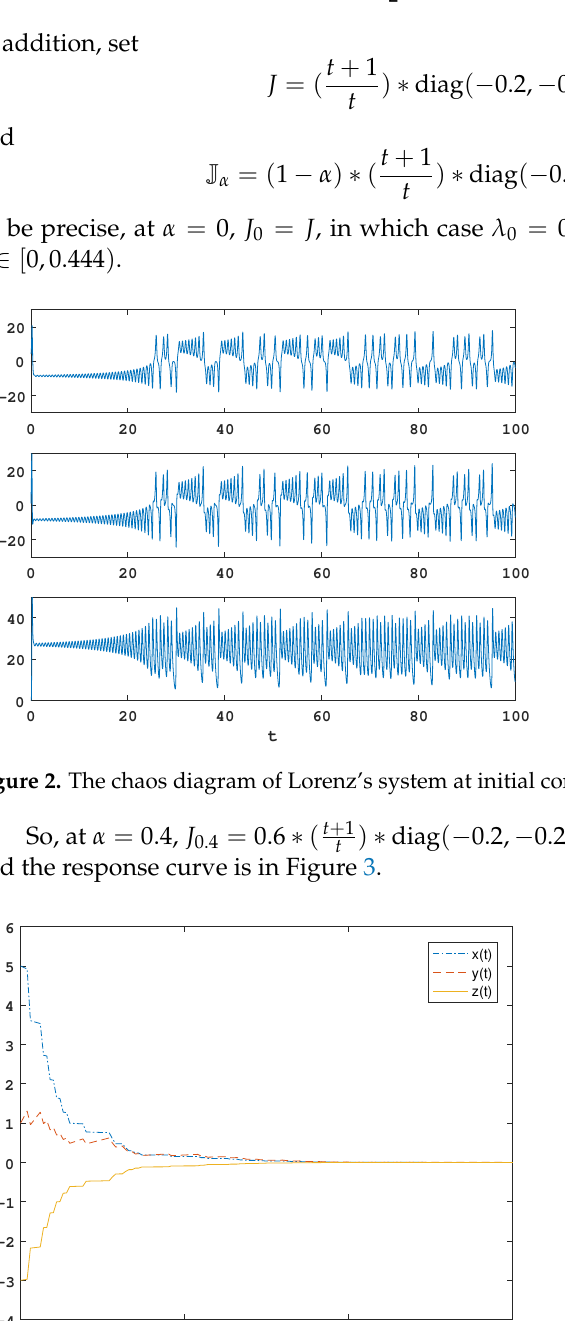
Figure 3. System of Lorenz after control at α =